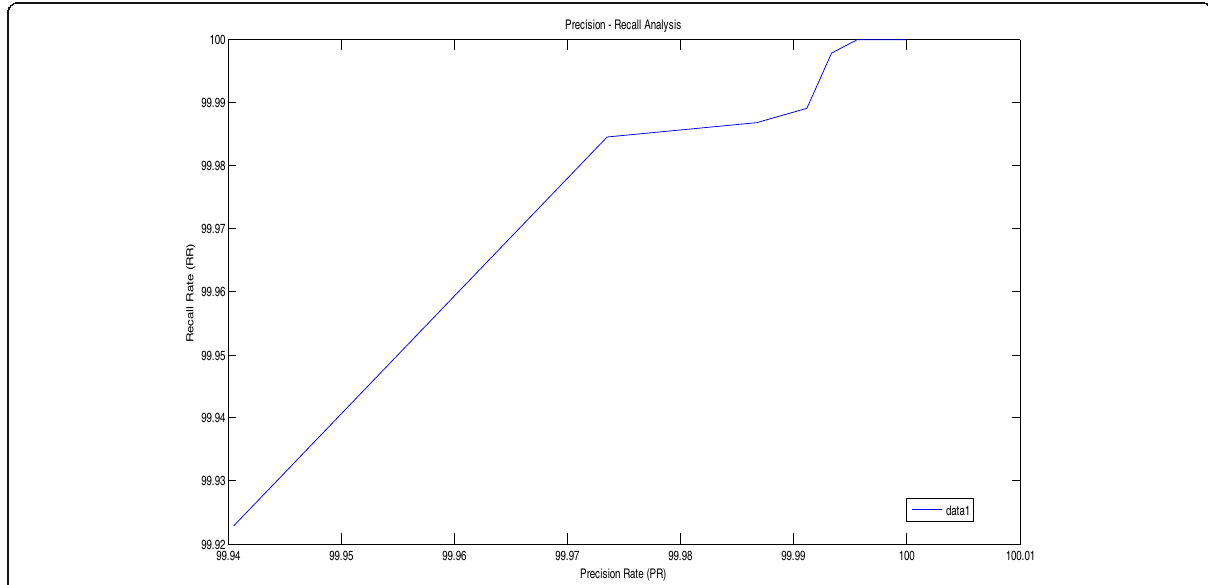
Fig. 6 Precision – Recall Analysis of the Proposed